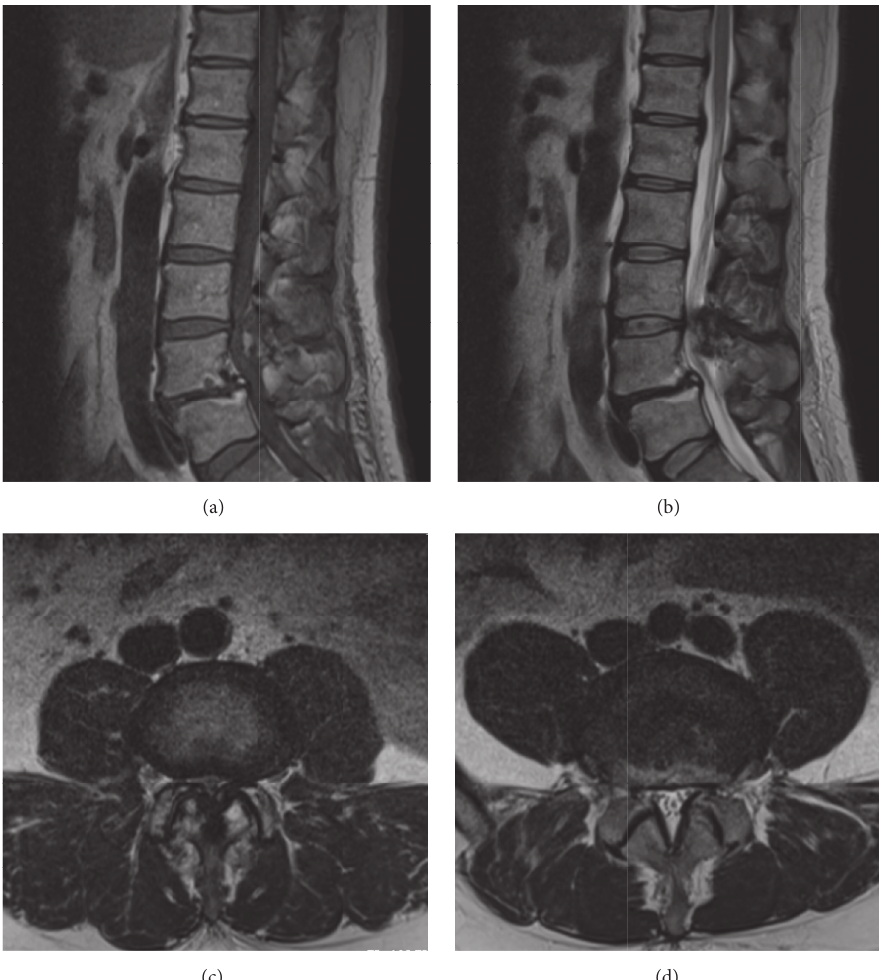
Figure 2: Preoperative magnetic resonance imaging. Sagittal T1-weighted image (a); sagittal T2-weighted image at the midspinal canal (b); axial T2-weighted image at the L3/4 level (c); axial T2-weighted image at the L4/5 level (d). Lumbar canal stenosis is seen at the L3/4 and L4/5 levels, with severe stenosis at